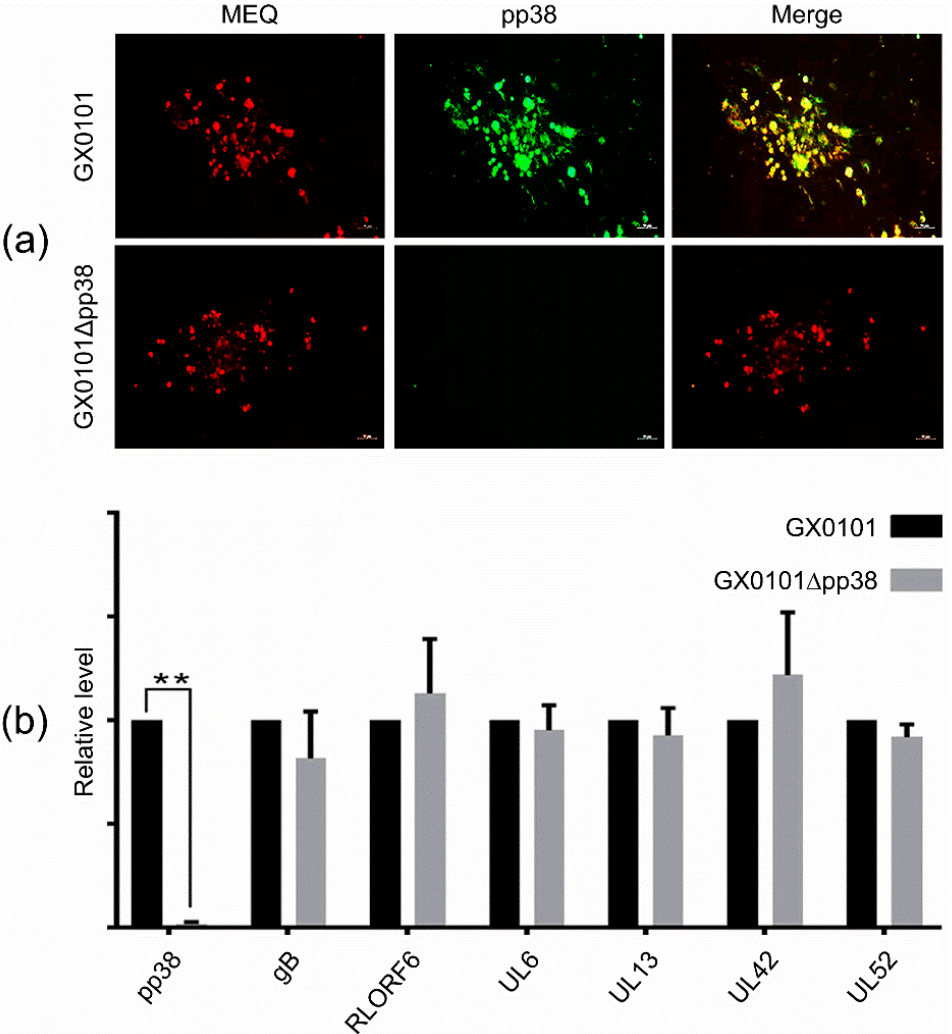
Figure 2. IFA staining and RT-qPCR analysis of the expression of viral genes in MDV-infected CEFs: ( a ) Expression of the MEQ and pp38 proteins in GX0101 or GX0101 ∆ pp38-infected CEFs, as detected by immunofluorescence assay (scale bar = 50 µm). ( b ) Relative expression levels of MDV-1 genes in GX0101- or GX0101 ∆ pp38-infected CEFs, as determined by RT-qPCR analysis. All of the experiments were independently repeated three times, and the gene expression levels were normalized to that of the MDV oncogene meq. Asterisks (*) indicate statistically significant differences between the pp38-deleted mutant and the parental GX0101; **, p < 0.01.